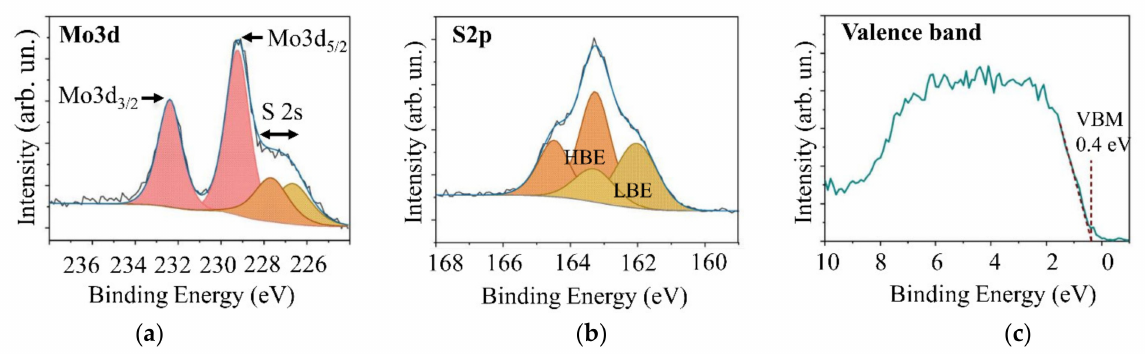
Figure 10. XPS spectra of ( a , b ) core level Mo3d and S2p and ( c ) the valence band of a relatively thick MoS x film obtained by on-axis RPLD.